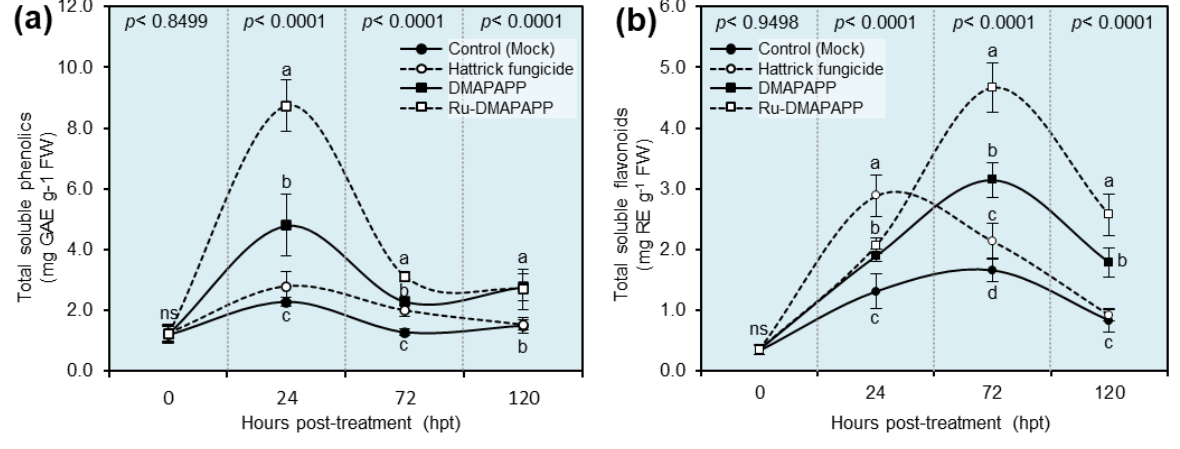
Figure 6. Effect of two bis-chalcone derivatives, DMAPAPP and Ru-DMAPAPP, on the non-enzymatic antioxidant defense compounds associated with fusarium wilt disease caused by Fusarium equiseti on pepper plants under greenhouse conditions. ( a ) Total soluble phenolics (mg GAE g − 1 FW) and ( b ) total soluble flavonoids (mg RE g − 1 FW). Values represent the means ± standard deviations (means ± SD). Different letters indicate statistically significant differences between treatments using the Tukey–Kramer honestly significant difference test (Tukey HSD; p < 0.05).